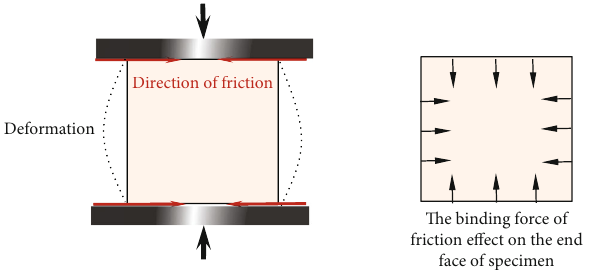
Figure 11: Calculated areas and the interrelationship of elastic strain energy and dissipation